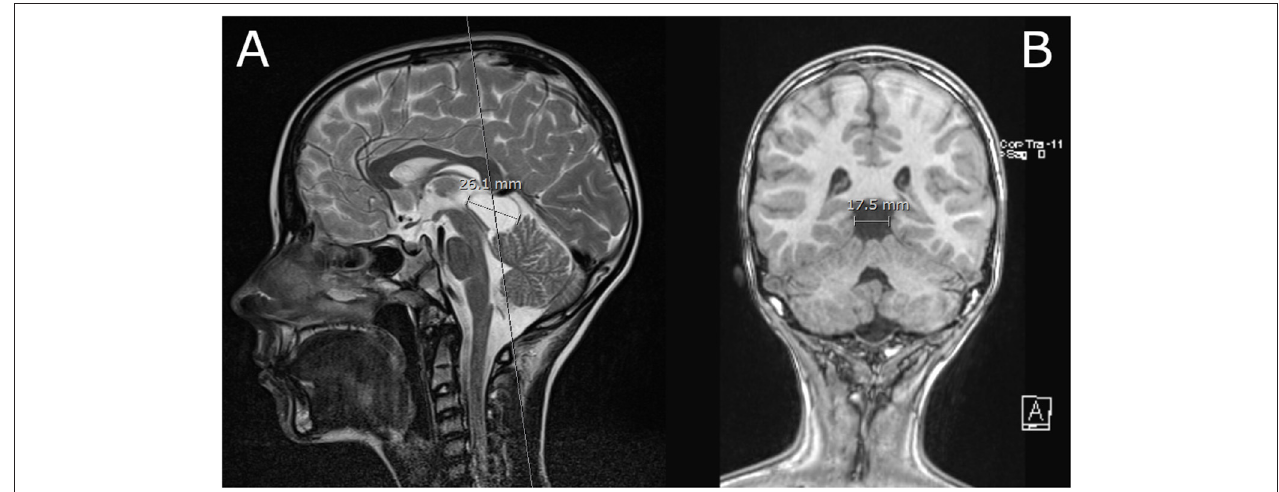
FIGURE 2 | (A) T2 weighted image in mid-sagital plane; Large PCL that slightly displaces tectal plate and vermis. The aqueduct is patent, there is no evidence of obstructive hydrocephalus. (B) T1 weighted image of the PCL in the coronal